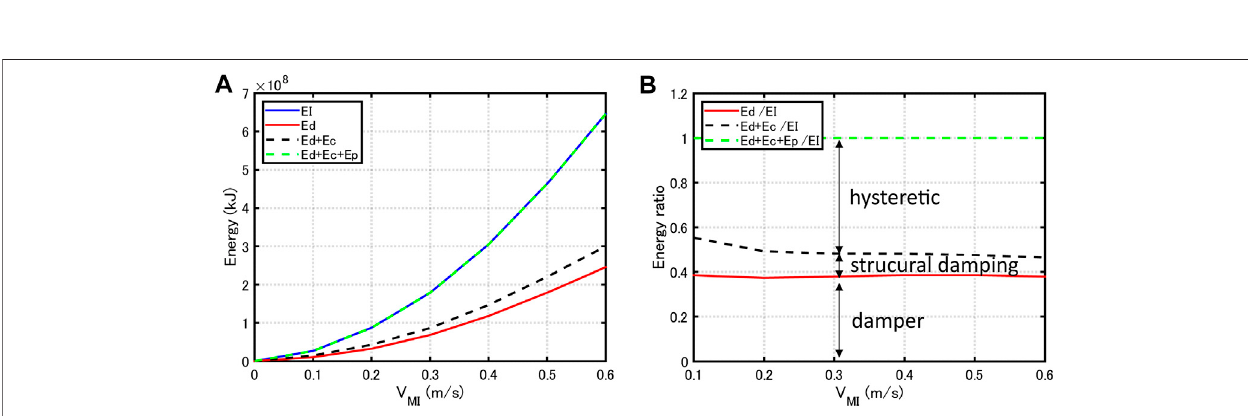
damper quantity under the critical double impulses with various input levels V DI (cid:1) 0 . 20 , 0 . 60 , 1 . 00 [ m / s ] . It can be